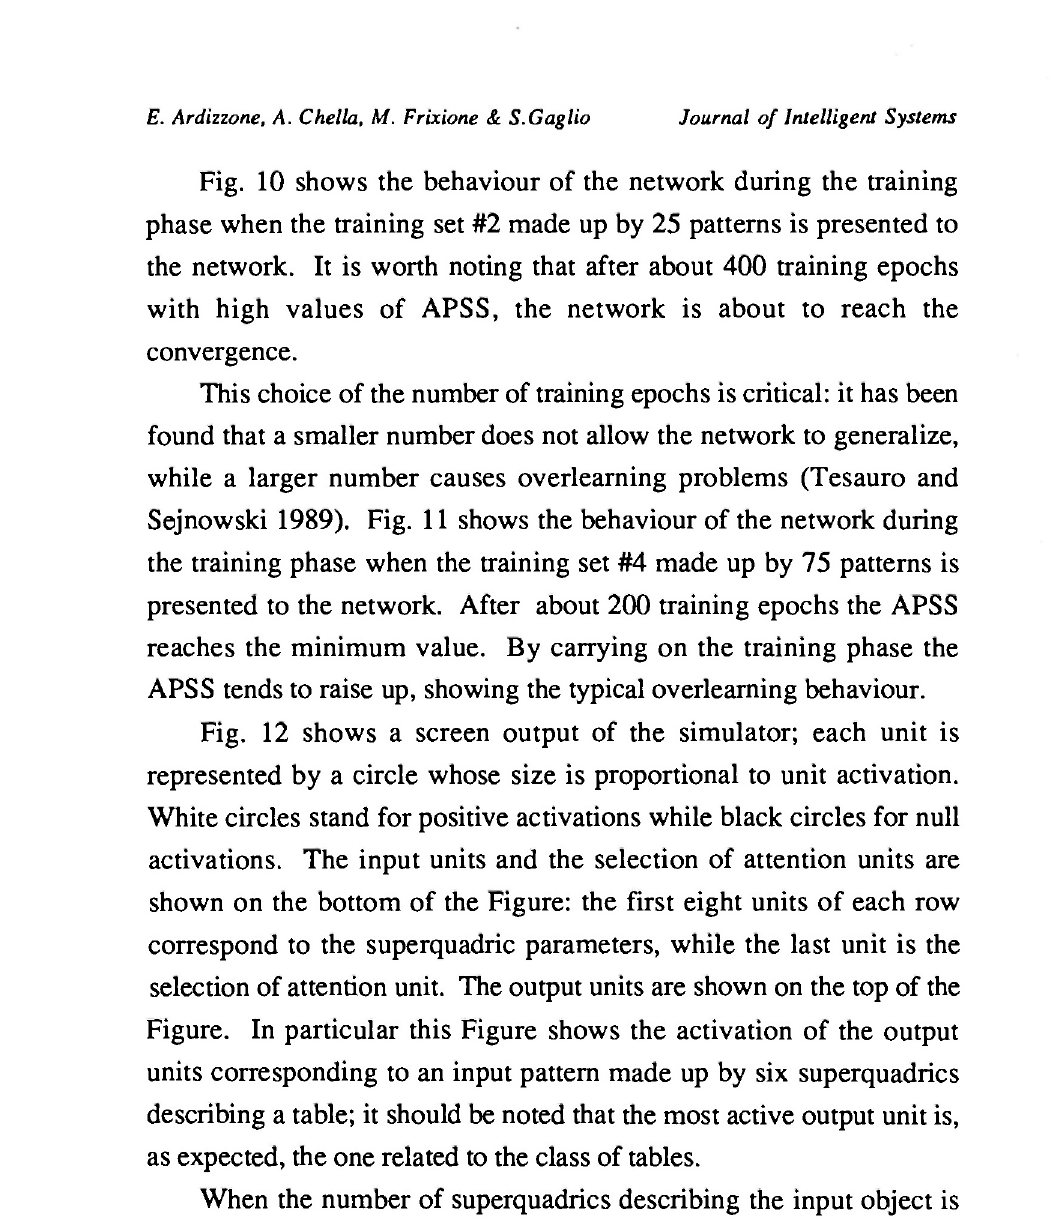
White circles stand for positive activations while black circles for null activations. The input units and the selection of attention units are shown on the bottom of the Figure: the first eight units of each row correspond to the superquadric parameters, while the last unit is the selection of attention unit. The output units are shown on the top of the Figure. In particular this Figure shows the activation of the output units corresponding to an input pattern made up by six superquadrics describing a table; it should be noted that the most active output unit is, as expected, the one related to the class of